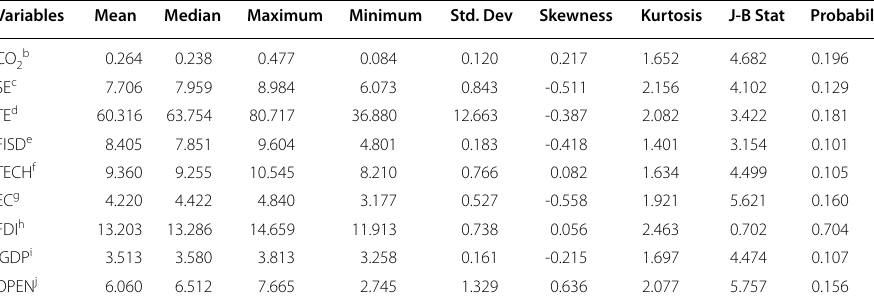
a Data source: the data was collected from World Development Indicators (see Table 2 for more details) b The unit of CO 2 emissions was kg per 2015 US$ of GDP